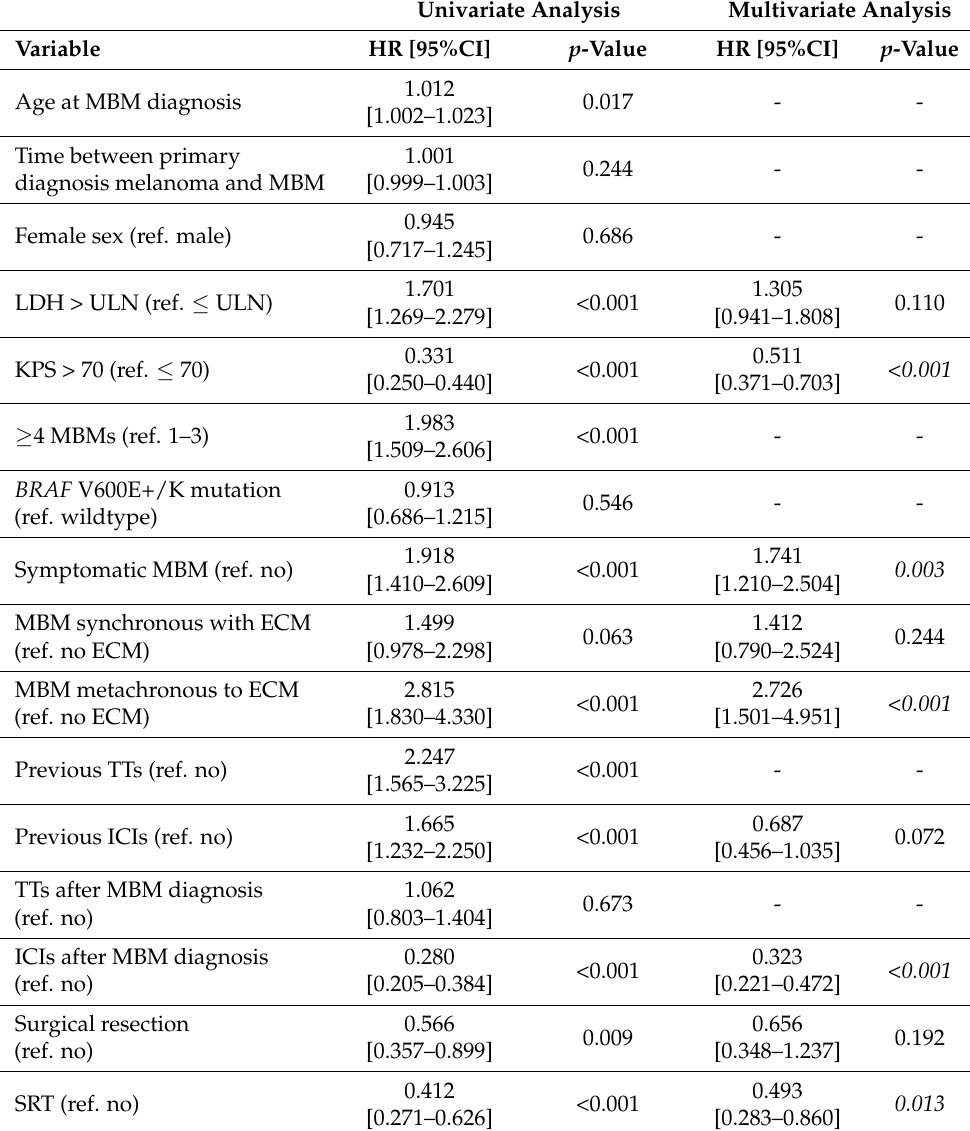
Table 3. Cox proportional hazards model for overall survival of patients diagnosed with melanoma brain metastasis (MBM) in the post-2015 cohort ( n = 278). Univariate